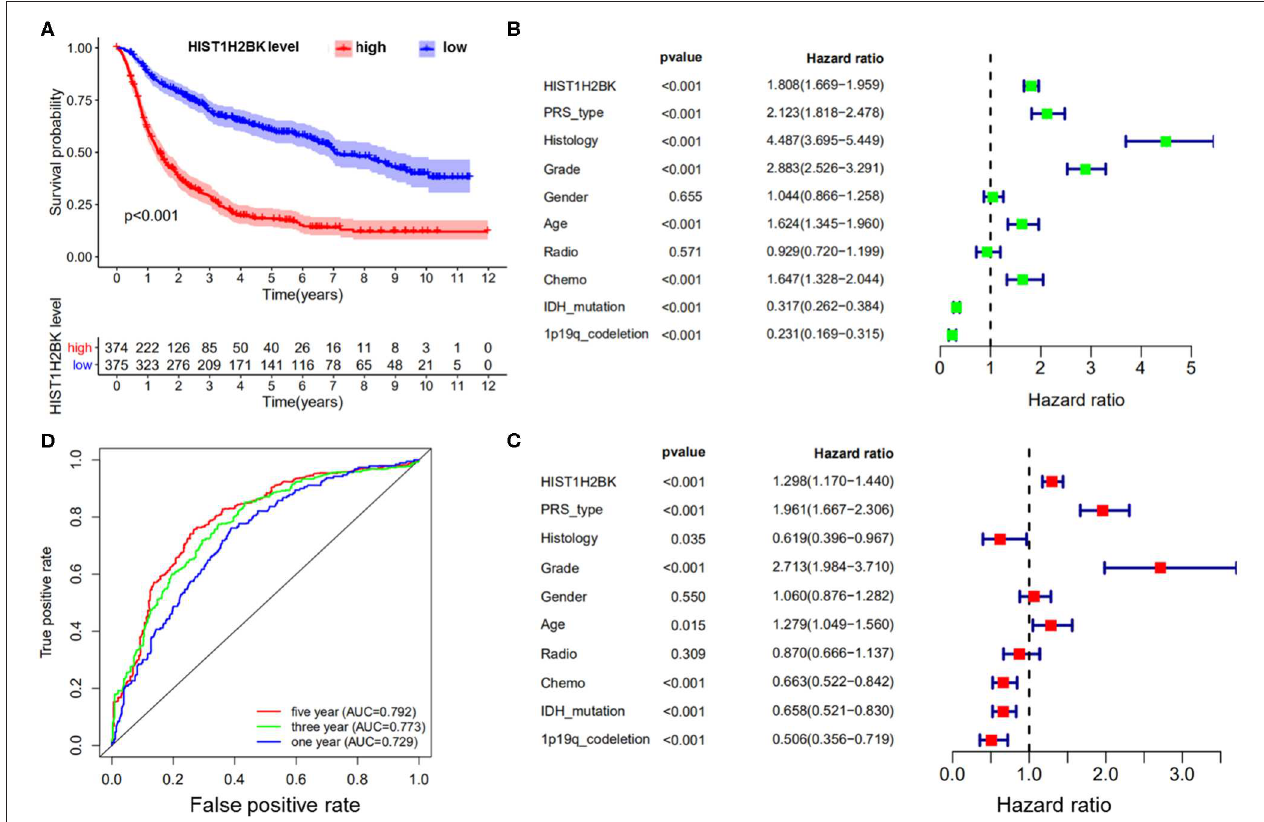
FIGURE 1 | Bioinformatics analysis of HIST1H2BK using the CGGA database (LGG + GBM, n = 749). (A) Survival analysis of patients with glioma in the high HIST1H2BK and low HIST1H2BK groups. Red indicates high expression and blue indicates low expression. P < 0.001. (B) Univariate analysis of HIST1H2BK. (C) Multivariate analysis of HIST1H2BK. (D) Receiver operator characteristic curve analysis of HIST1H2BK. AUC, area under the curve.